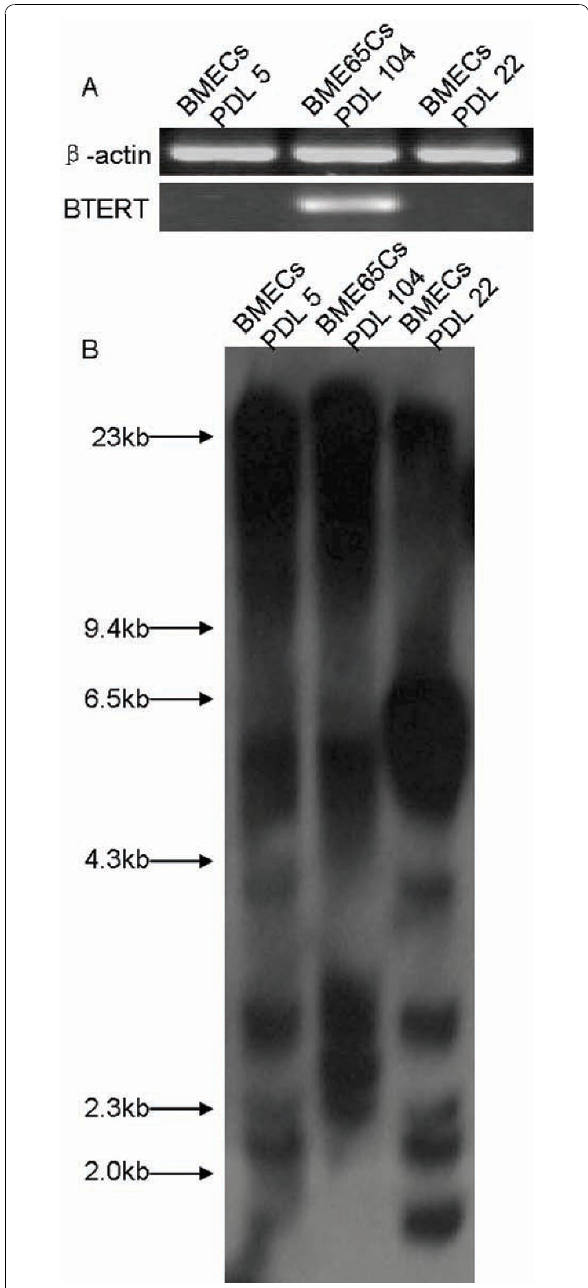
Figure 5 Detection of bTERT expression and analysis